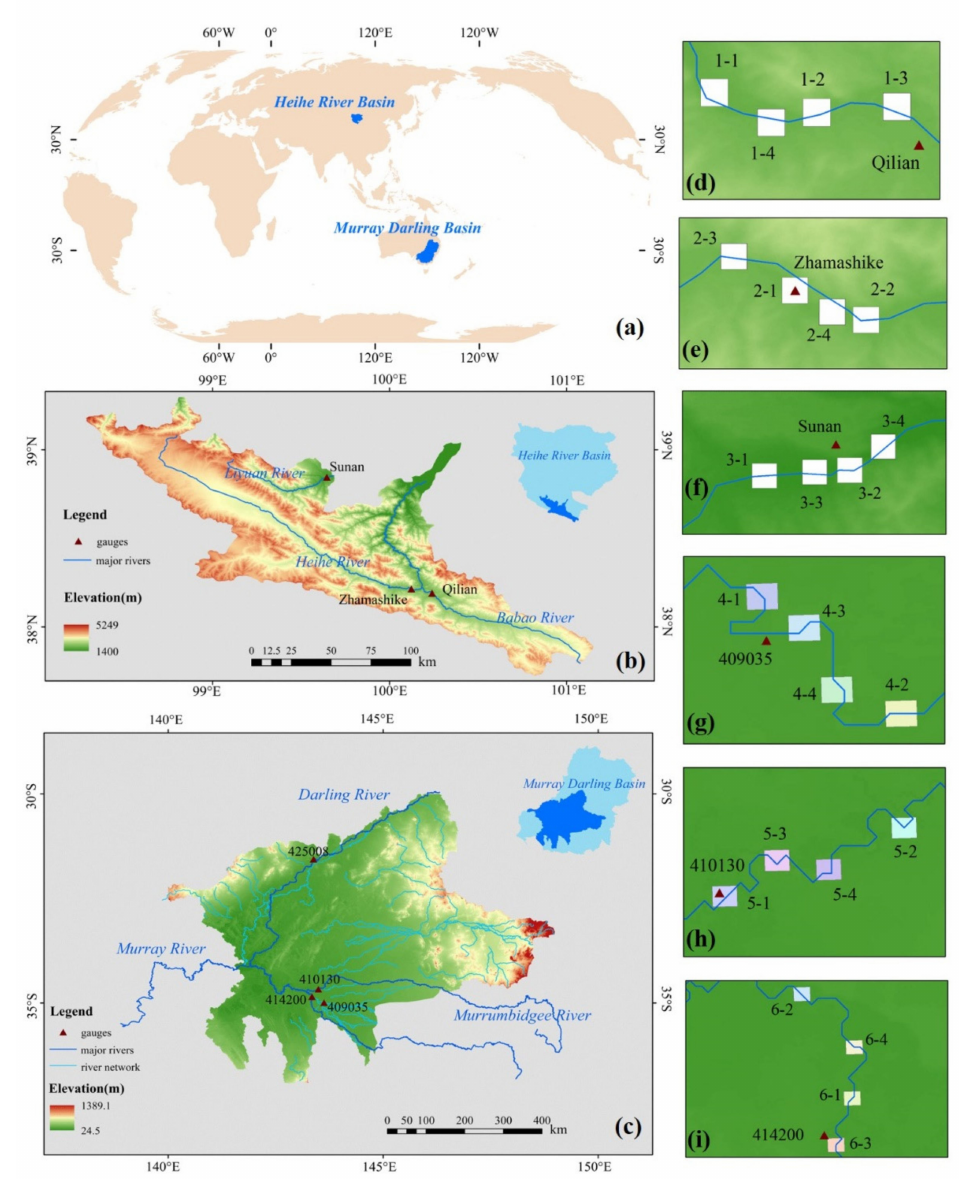
Figure 1. ( a ) Locations of two study areas: ( b ) the Heihe River Basin and its selected sites ( d – f ); and ( c ) the Murray Darling Basin and its selected sites ( g – i